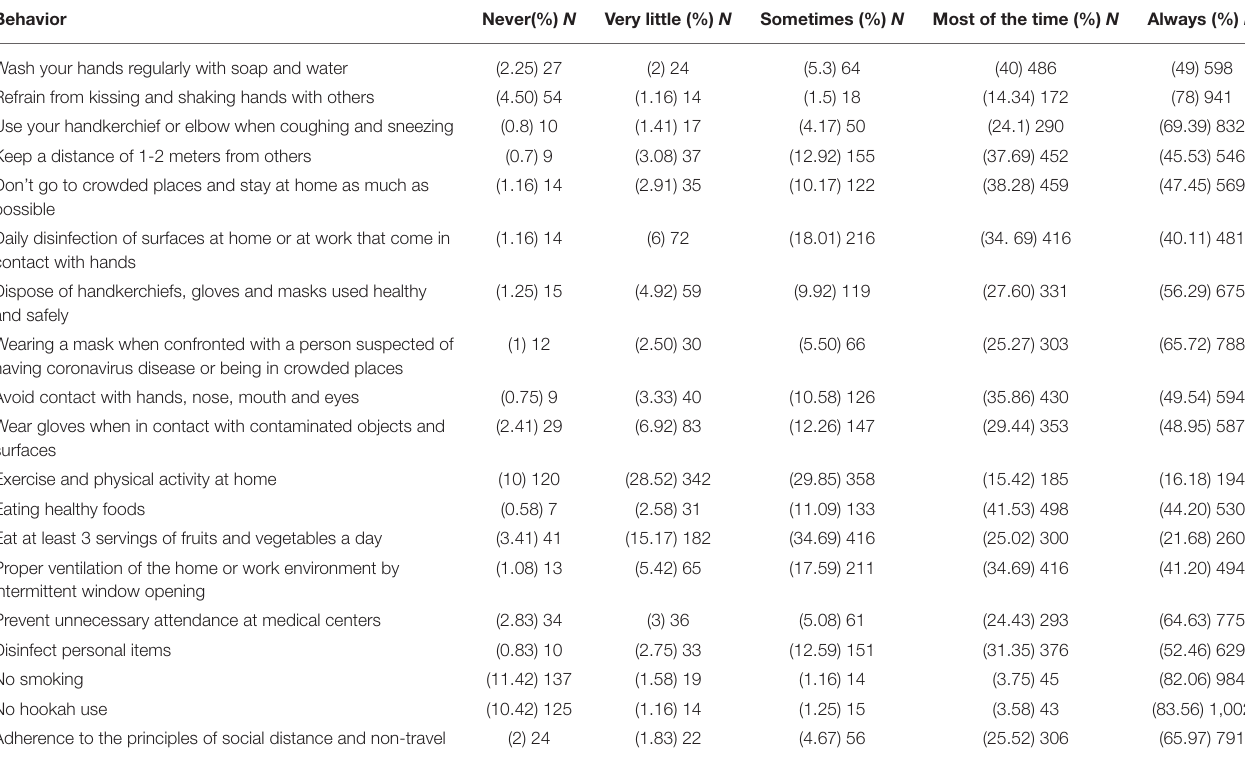
TABLE 2 | Frequency of subjects’ answers to questions related to preventive behaviors from COVID-19. Behavior Never(%) N Very little (%) N Sometimes (%) N Most of the time (%) N Always (%)